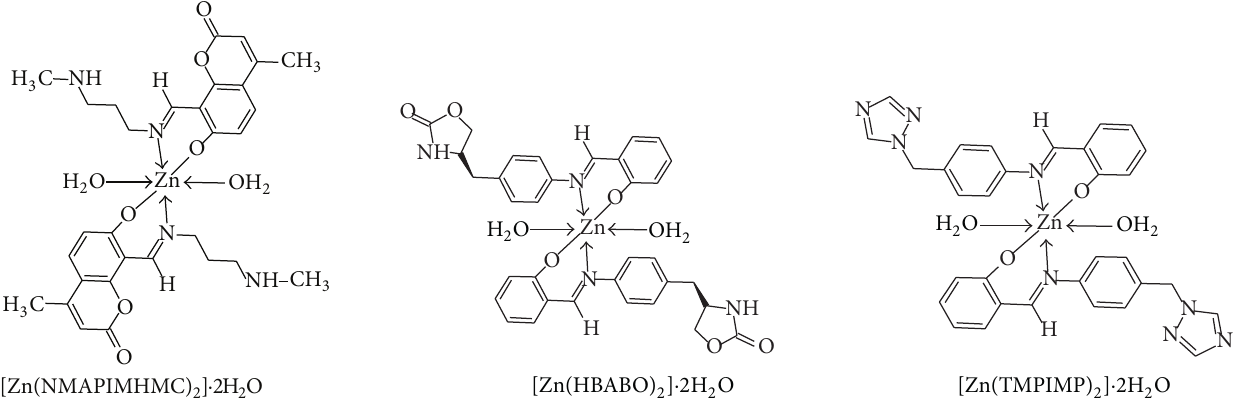
Table 3: Proposed structure of [ Zn(L)